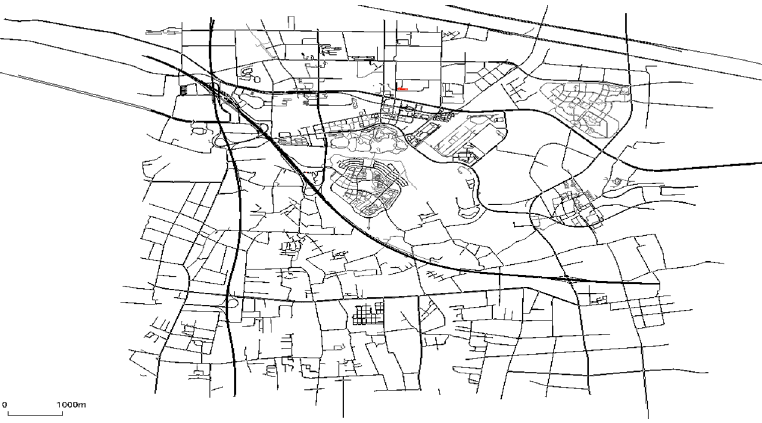
Figure 11. Map used in ns3 for route planning.